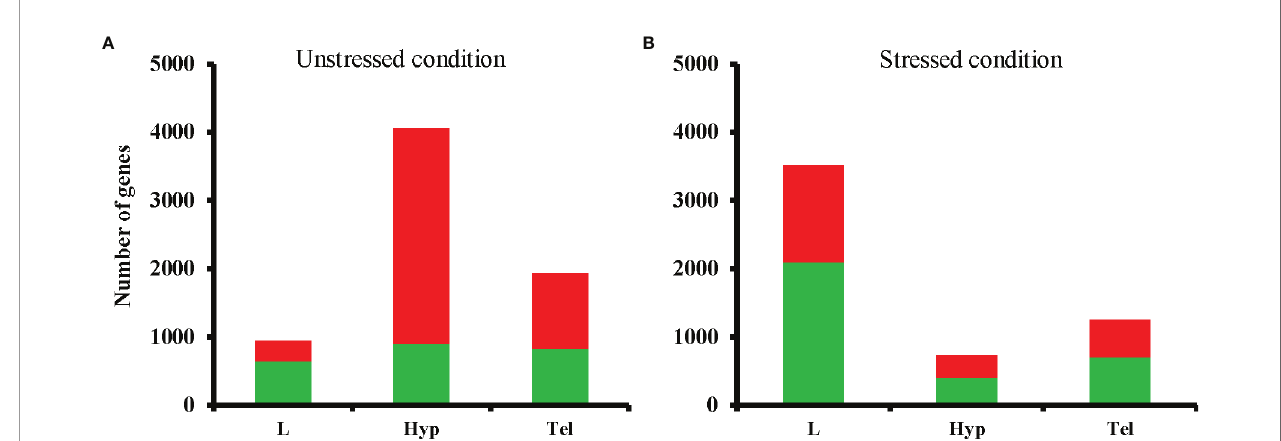
FIGURE 1 | Total numbers of differentially expressed genes (DEGs) in fl uoxetine-exposed groups compared to respective controls in unstressed (A) and stressed (B) conditions. The total numbers of DEGs are shown in a stacked format with downregulated and upregulated genes color-coded in green and red, respectively. L, larval head; Tel, telencephalon; Hyp, hypothalamus. ( Figure 3A ). Also, several pathways associated with neural cell signaling, neurotransmitter signaling, and regulation of synaptic junctions populated the highly affected pathways in both Hyp and Tel of the unstressed adults ( Figure 3A ).